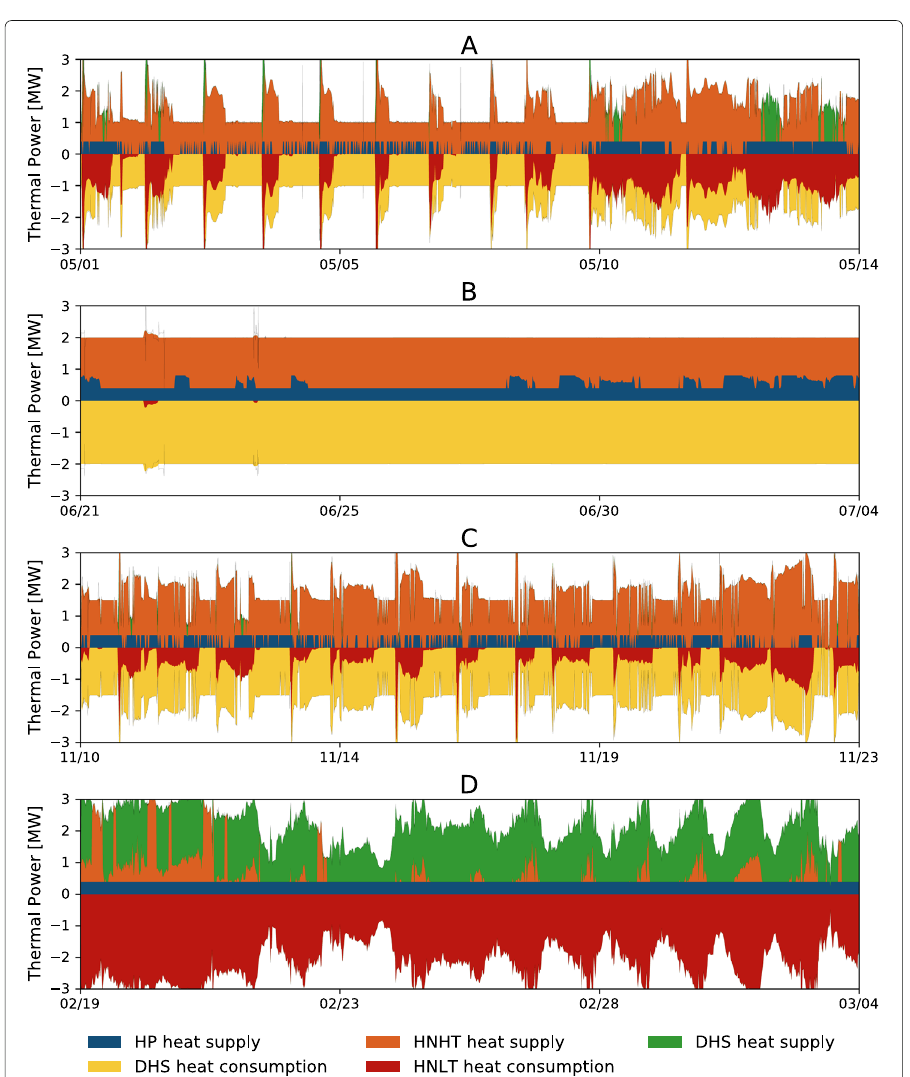
Fig. 5 Thermal power distribution throughout the different seasons in 2019: A spring, B summer, C fall, D